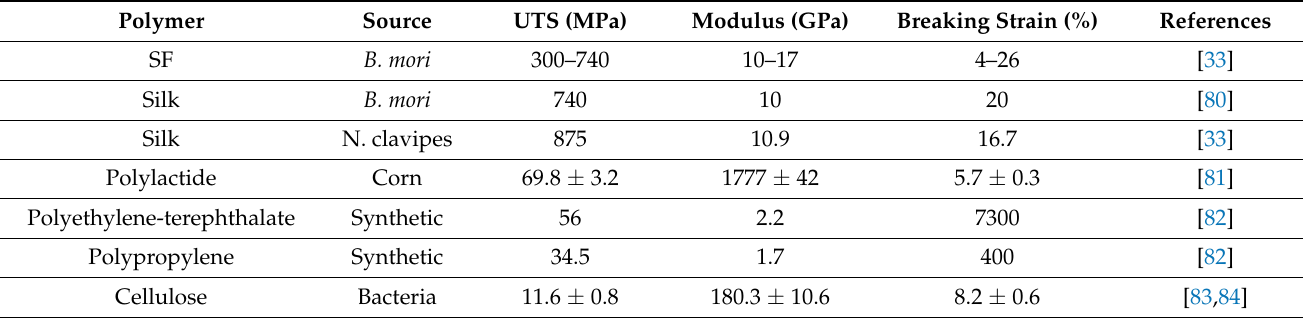
Table 1. Comparison between the mechanical properties of several